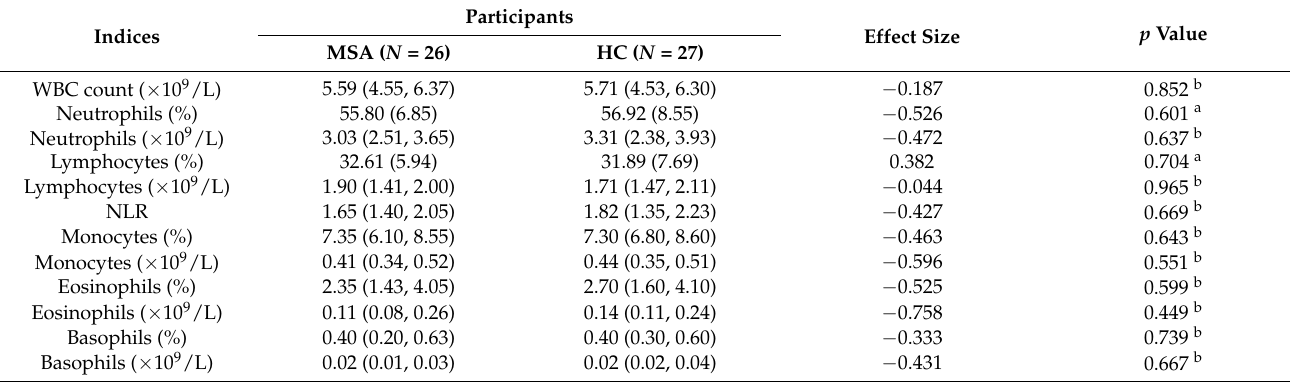
Table 3. Comparison of blood routine data between MSA and